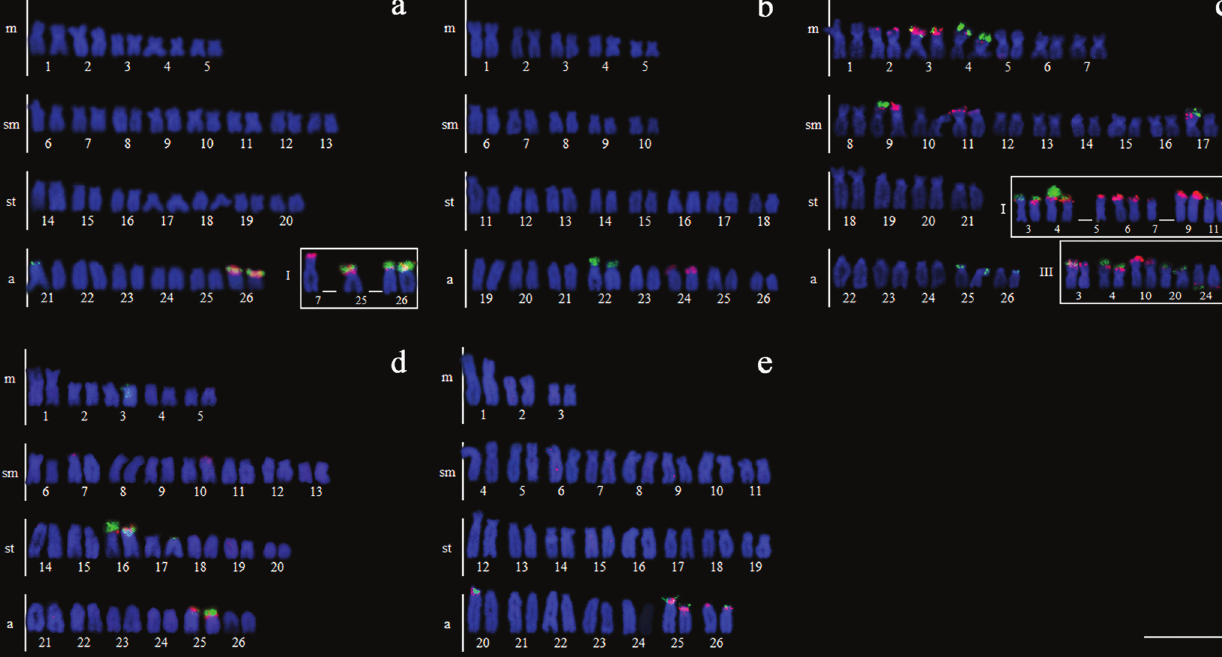
Fig. 3. Karyotypes after FISH with 5S rDNA probes (red) and 18S rDNA probe (green). In the boxes, the intra-population variations that represent distinct patterns of localization of ribosomal genes. a. Bryconamericus aff. iheringii (Ijuí River, pattern II) - box I: pattern I; b. B. aff. iheringii (Iguaçu River); c. B. coeruleus (pattern II) - box I: pattern I; box III: pattern III; d. B. cf. ecai ; e. B. cf. eigenmanni . Scales bar = 10